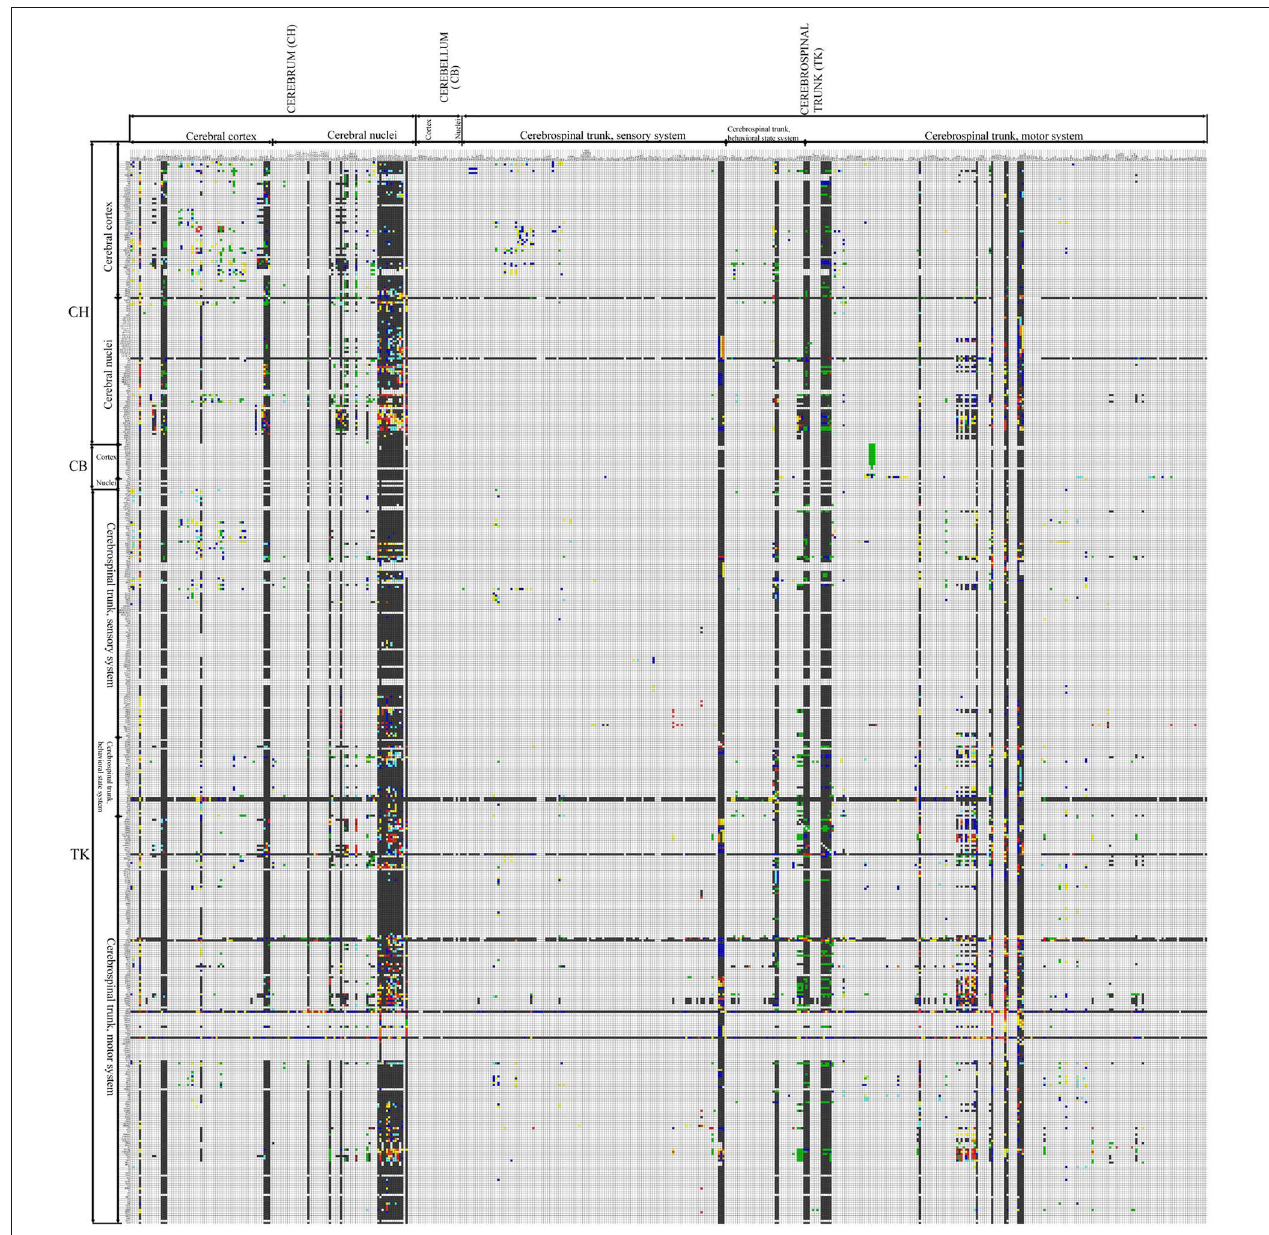
27,796, which represents more than 25% increase in connection data used to construct the matrix, from the 22,178 labeled cells ( Figure1 ; Bota and Swanson, 2007a) in the first version of the rat